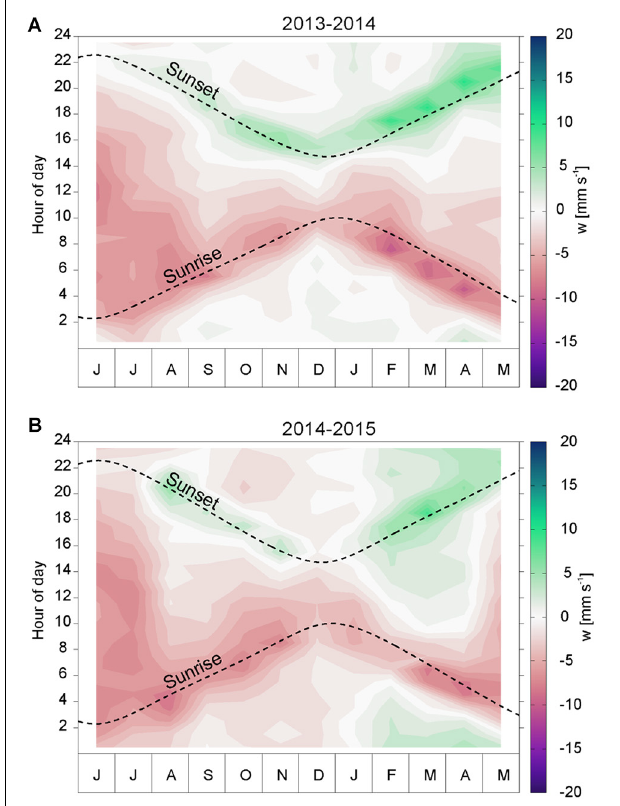
FIGURE 7 | Seasonal variation of the diel vertical migration velocity averaged between 100 and 500 m depth from June 2013 to May 2014 (A) and from June 2014 to May 2015 (B) . Contour intervals are 1 mm s-1. Dashed lines show the times of local sunrise and